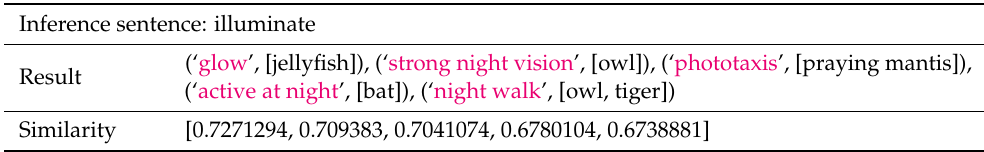
Table 15. Semantic reasoning result of function.